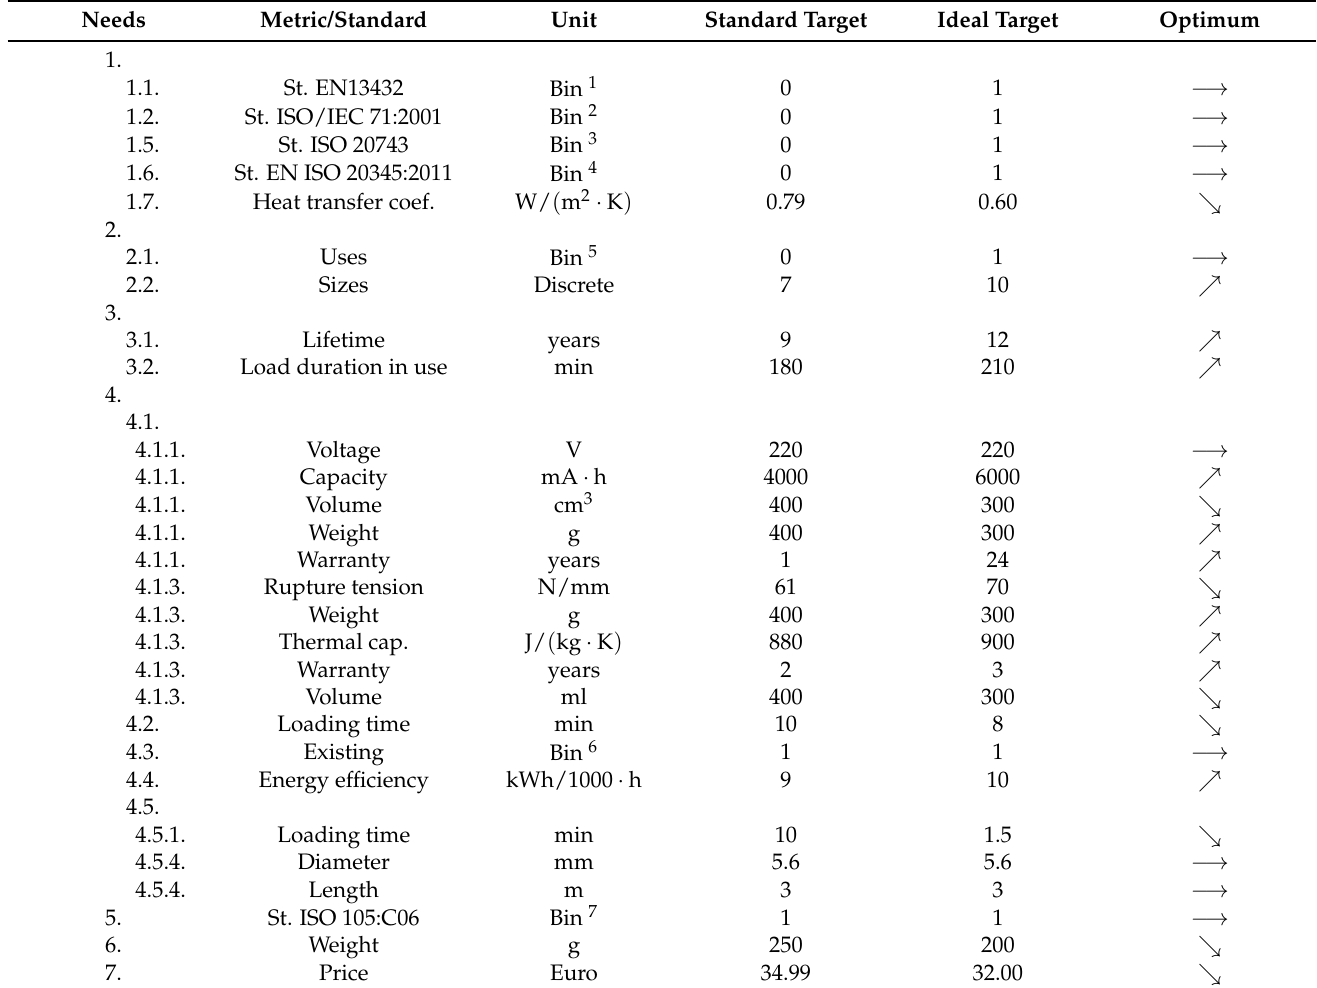
Table 7. Product specifications (including metrics and respective target values).